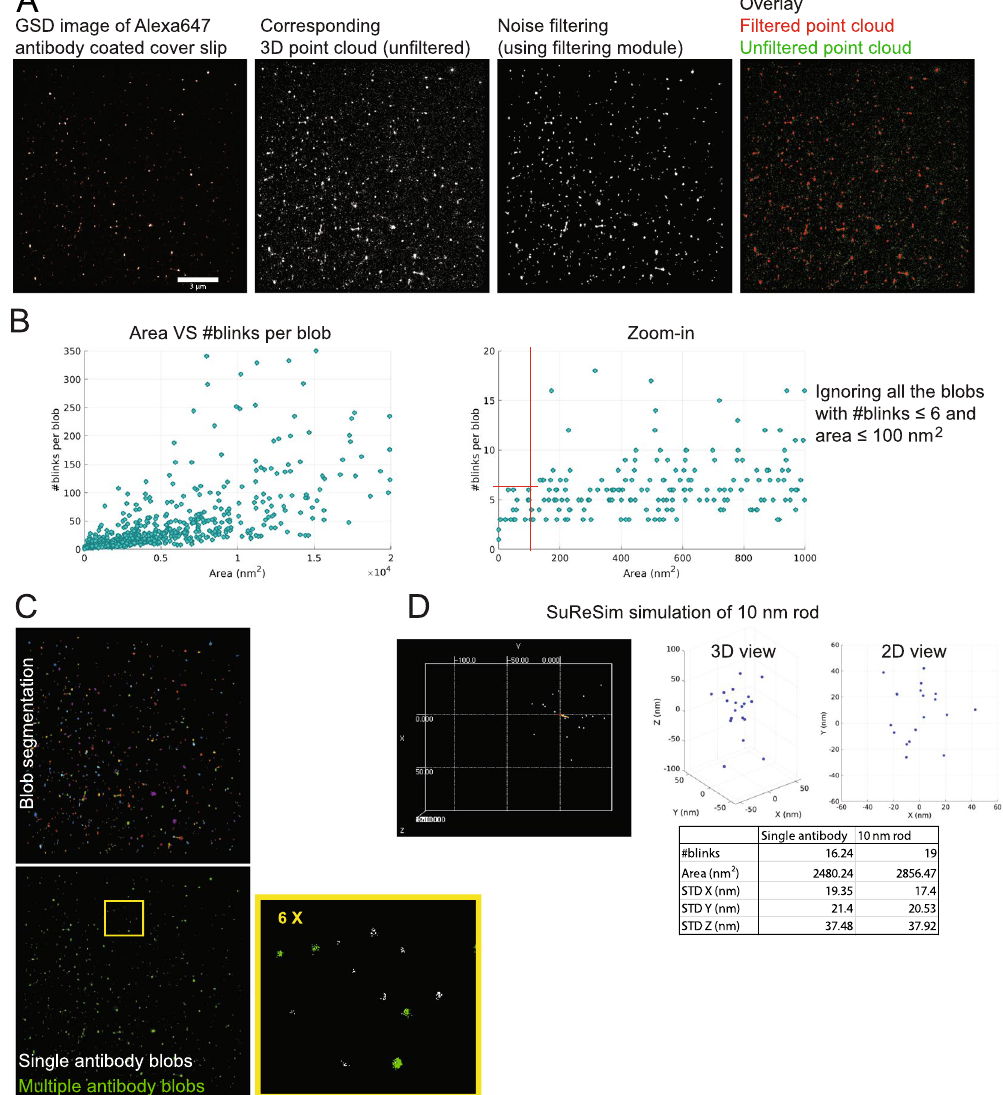
Figure 7. Experimental single antibody blinking data matches simulated data obtained for a 10 nm rod using SuReSim software. ( A ) A super-resolution GSD image of a cover slip coated with Alexa647-conjugated anti- rabbit secondary antibodies was imaged and the GSD image, unfiltered 3D point cloud and filtered point cloud, processed using filtering module 4 of the 3D SMLM Network Analysis pipeline (Fig. 1C) to retain blobs and remove noisy blinks, are shown. ( B ) Segmentation module 5 (Fig. 1C) was applied to the data to obtain the individual blobs and plots of #blinks per blob vs blob area are shown. Blobs with area ≤ 100 nm 2 all had fewer than 6 blinks (red lines) and we removed all blobs with fewer than 6 blinks and with area ≤ 100 nm 2 . ( C ) Single and multiple antibody blobs were identified using K-means clustering (K = 2) based on the extracted blobs’ features. By identifying the single antibody blobs, we derive the blinking data from an isolated protein experimentally. ( D ) We used the derived blinking data from the real single antibody blobs to image a rod of 10 nm length using SuReSim software 47 . The table shows the average standard deviation for the spread of the blinks from the blobs for the experimental data derived from a single antibody and for the simulated (SuReSim) imaging of a 10 nm